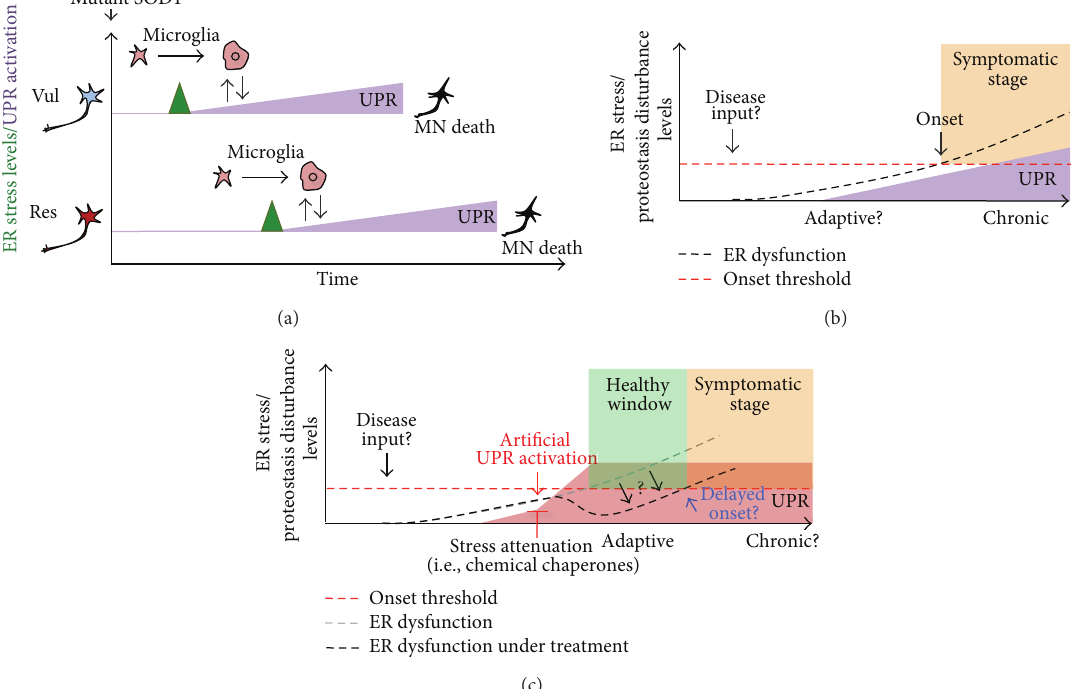
Figure 4: ER stress and the selective neuronal vulnerability in ALS. (a) Schematic representation of ER stress levels (green label) and UPR activation (purple label) in the two subgroups of neurons that have been identified in mutant SOD1 mouse models of ALS: one population that dies early (vul, vulnerable, blue) and another that dies later during disease progression (res, resistant, red). Activation of stress markers is a common feature detected in Vul and Res motoneurons. However, vul motoneurons express these stress markers earlier than de res neurons. The UPR is activated in both subgroups of neurons. UPR activation also correlates with microglial activation in both groups. It is not known what determines the resistance of Res cells in the disease. (b) Time-course of ER stress levels and UPR activation in familial ALS models. ER stress and protein disturbance increase during ALS progression (“ER dysfunction,” black dashed line). During the presymptomatic stage of the disease, UPR activation might represent an adaptive response that attenuates ER stress levels. Over time, the stress condition exceeds the capacity of the cell to manage protein folding stress and pro-apoptotic pathways are activated. This shift “onset threshold” in UPR signaling regulation could be associated with motoneuron dysfunction/loss and the onset of the disease. During the symptomatic stage, a strong and chronic UPR activation occurs. (c) Possible therapeutic approaches to modulate the UPR in ALS. An earlystage preventive treatment may modulate UPR levels to enhance the adaptive capacity of motoneurons and reduce ER stress levels or other proteostasis disturbances. This may delay disease onset and disease evolution “healthy window”. The therapeutic approaches include gene therapy to deliver active UPR components and the use of smallmolecules that selectively activate specific UPR signaling branches (pharmacologic approaches) or act as chemical chaperones to alleviate global ER stress. This reduction in ER stress levels in motoneurons could also be achieved by modulating glial